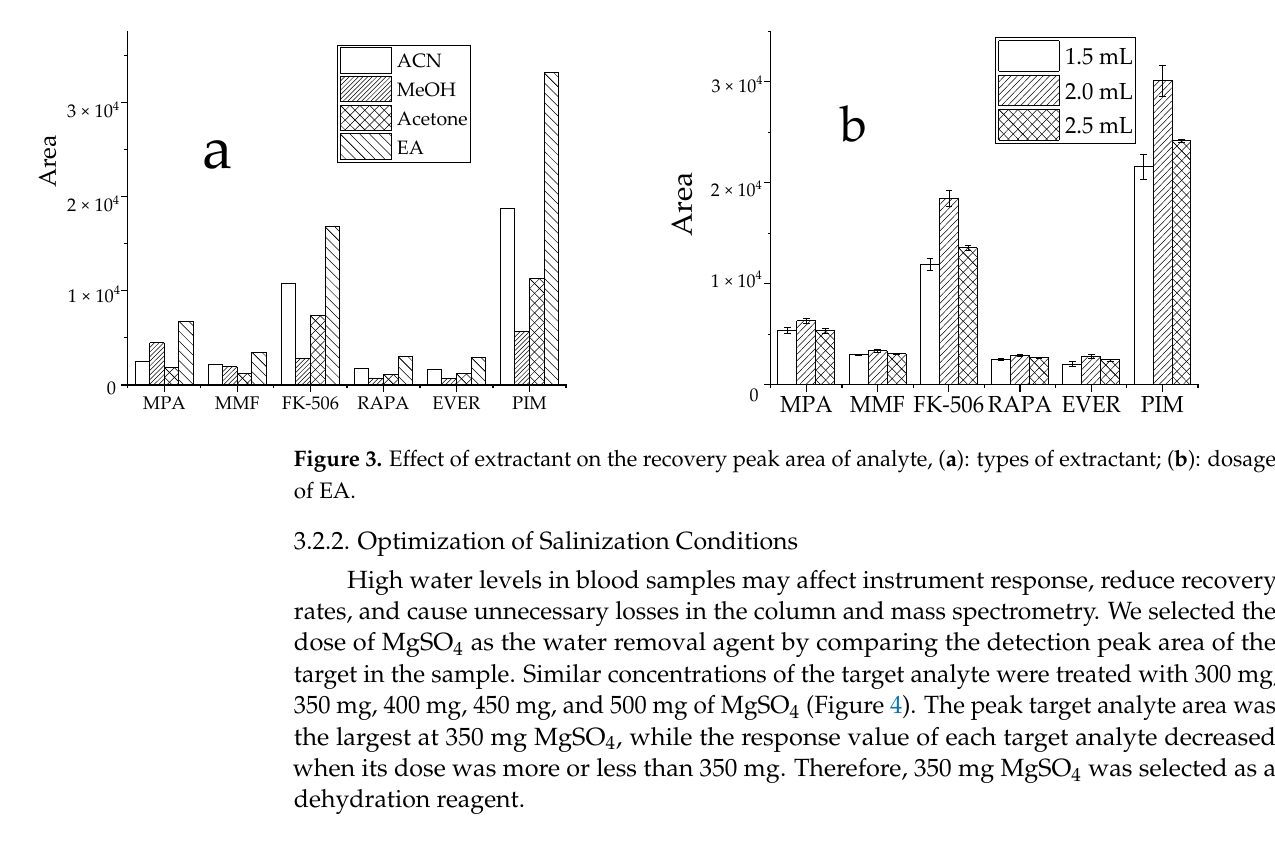
Figure 4. Effect of MgSO4 dosage on recovery peak area of target analyte.